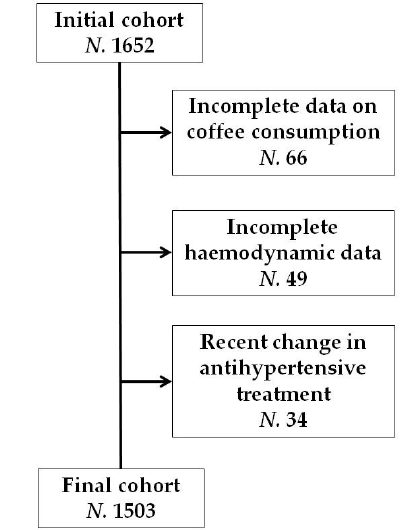
Figure 1. Flow diagram of study